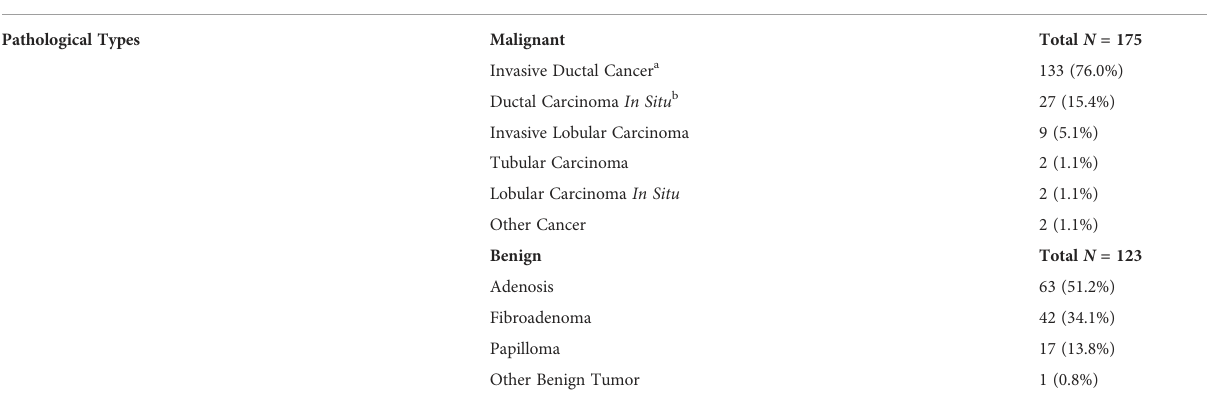
TABLE 2 Pathological types of lesions in the study